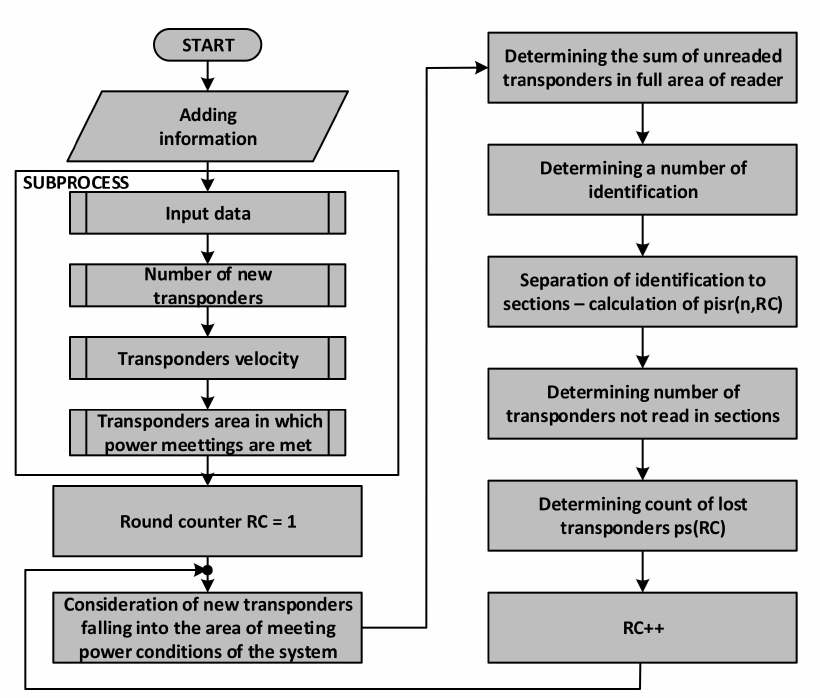
Figure 15. A simplified diagram of the identification system procedure using the proposed